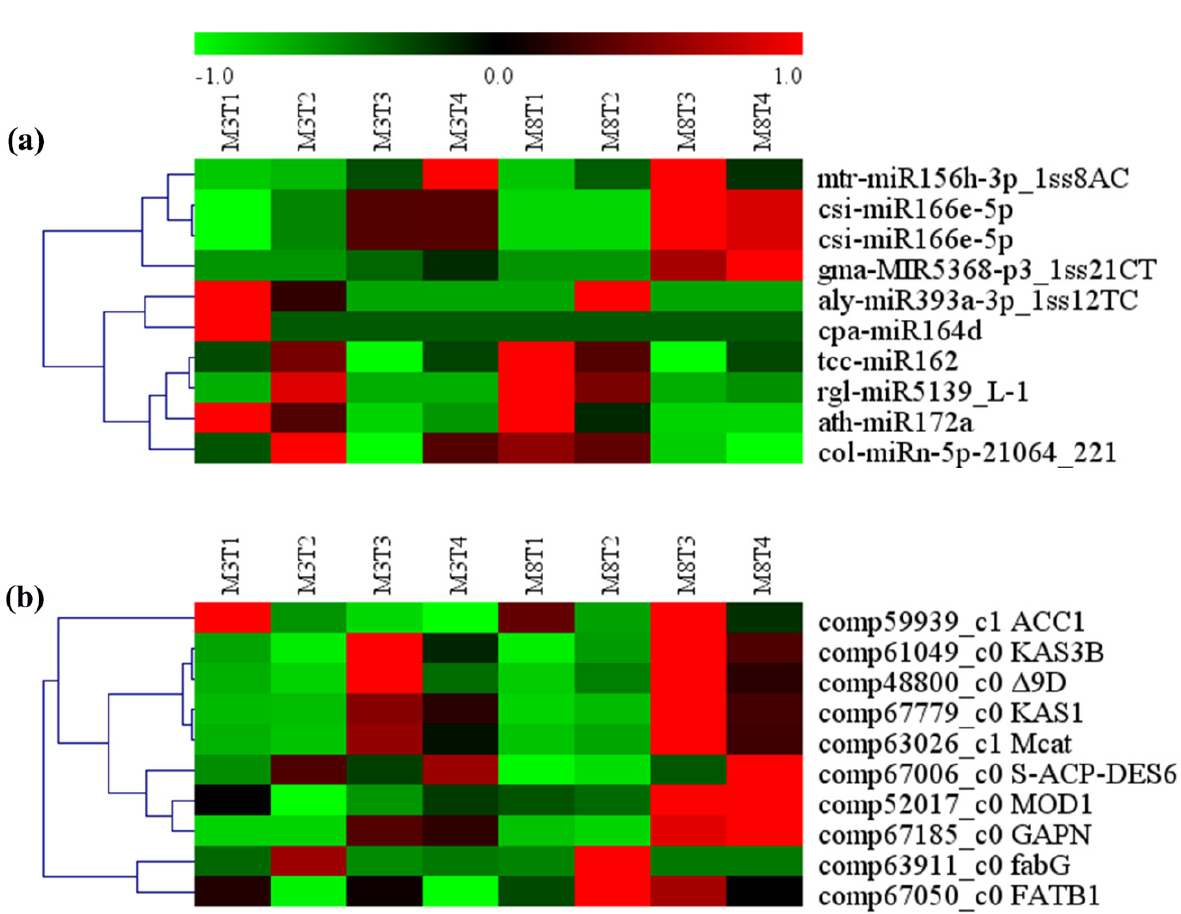
Figure 8. Heat map analysis of ( a ) predicted differentially expressed miRNAs, and ( b ) their target genes, involved in lipid metabolism in the seeds of the ‘M3’ and ‘M8’ cultivars at four developmental stages. Red and green colors indicate high levels and low levels, respectively, of the miRNAs and their targets.